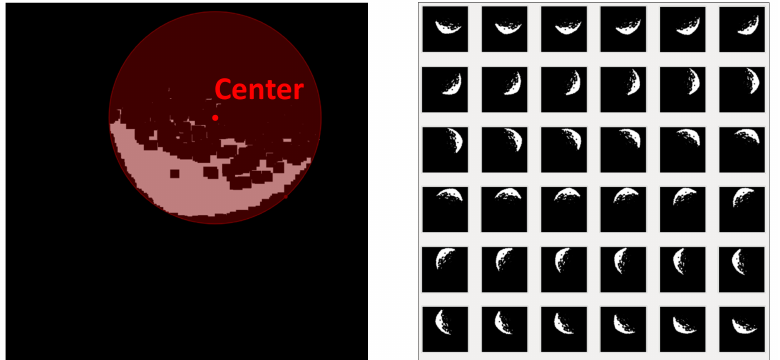
Figure 5. Image rotation operation. It should be noted that all of our annotations were made in the original image, as shown in Figure 4. However, due to the poor visualization of the original images, we put the annotation results on the morphologically processed images.